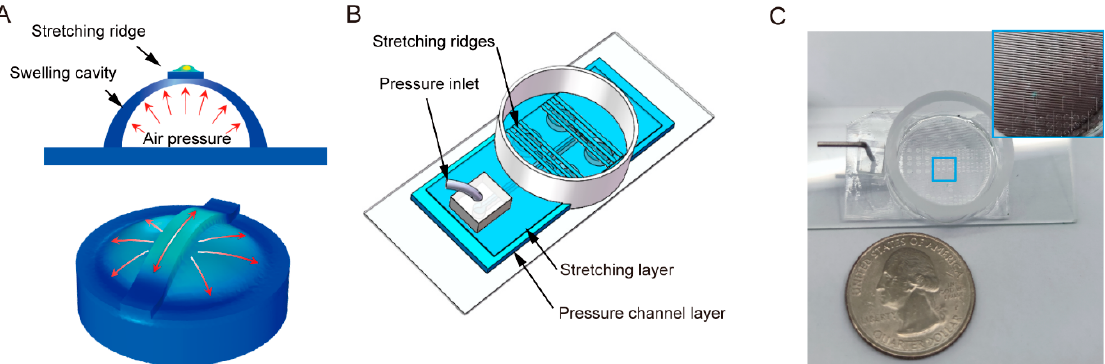
Figure 1. Ridge surface-dictated cell stretching chip. ( A ) Concept of cell stretching chip. Up panel is a cross-sectional view of the stretched cavity under air pressure. Down panel is a 3D view of the stretched ridge on the surface of the elastic stretching layer. ( B ) Schematic and ( C ) physical pictures of the stretching device. The stretching chip consists of three layers, i.e., top elastic membrane layer with a periodic ridge structure, middle pressure control layer with a circle cavity array, and a bottom glass substrate.